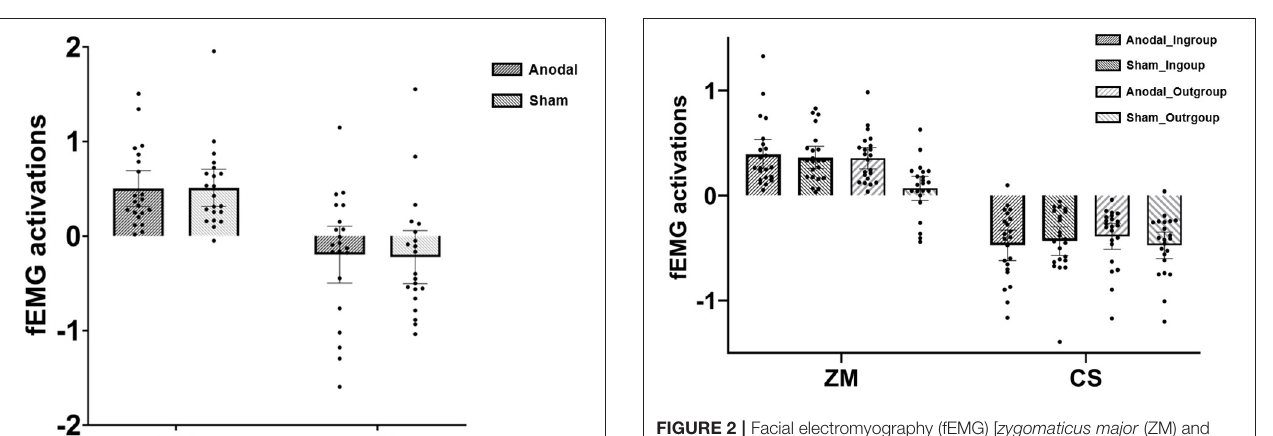
FIGURE 2 | Facial electromyography (fEMG) [ zygomaticus major (ZM) and corrugator supercilii (CS)] activations under various conditions in Experiment 2; dots refer to individual